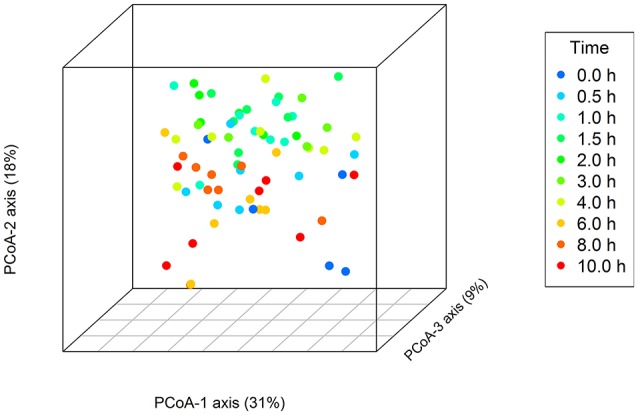
Principal Coordinate Analysis of samples at the OTU level using weighted unifrac distances, with samples labeled by time point as indicated by the key.